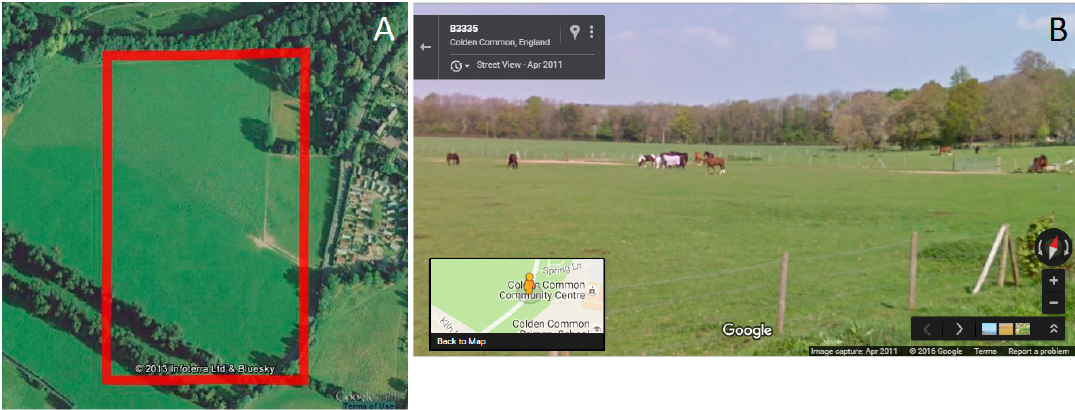
Figure 2. An example of pasture land in an image from the Cropland Capture game. ( A ) The image as seen by players of the game. Players overwhelmingly classified this as being cropland; and ( B ) a view of the same parcel from ground-level as seen in Google Street View, showing that this field is pasture, not cropland.